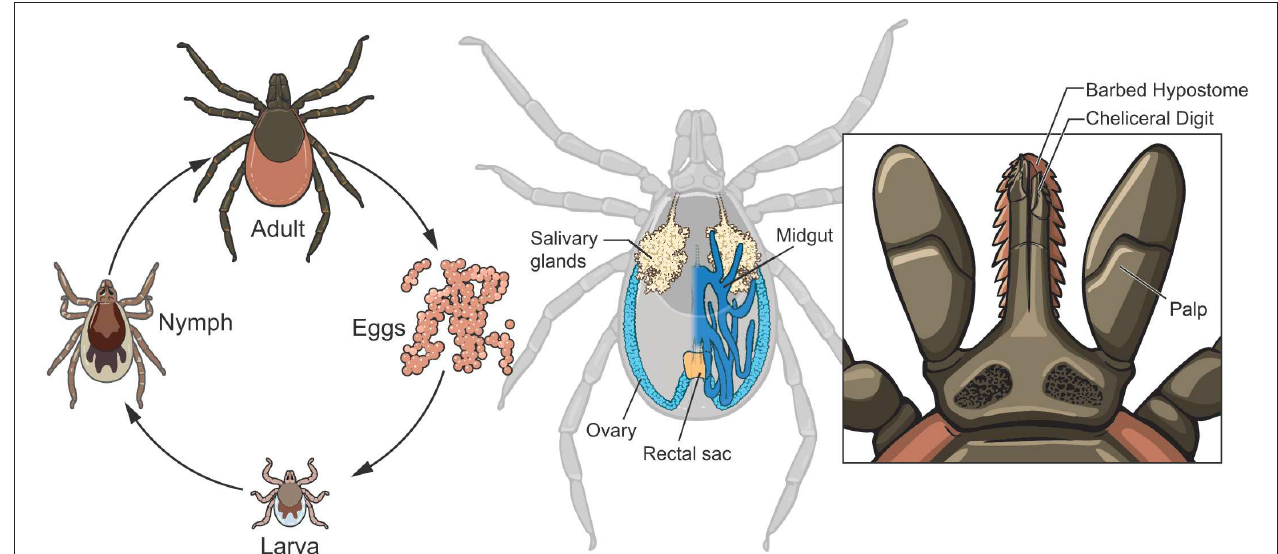
FIGURE 1 | Life cycle and anatomical features of Ixodes scapularis . After hatching from eggs, I. scapularis progresses through 3 developmental stages: larval, nymphal and adult (left panel). Note the morphological differences that occur during each molt (see text for additional details): size successively increases and the larval-nymphal molt produces an additional pair of legs while sexual development occurs during the nymphal-adult molt. The midgut (dark blue with only the right half depicted, middle panel) is the site of digestion of the bloodmeal and is a significant entry route for microbes. The salivary glands (beige) are the exit ramps for transmission of infectious microbes to vertebrate hosts. Ovaries (light blue) are also organs of transmission for those symbionts transmitted to the progeny. The anatomy of the tick mouthparts (right panel) facilitates the feeding of I. scapularis , with the saw-like chelicerae cutting through host tissues and vessels to gain access to the